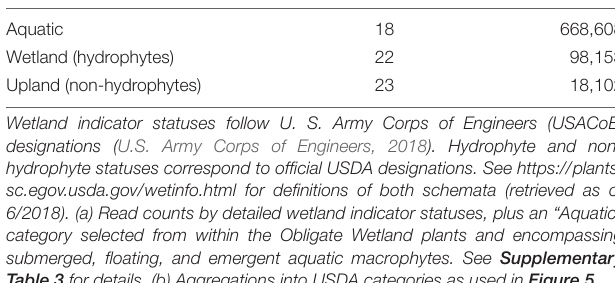
Frontiers in Environmental Science |